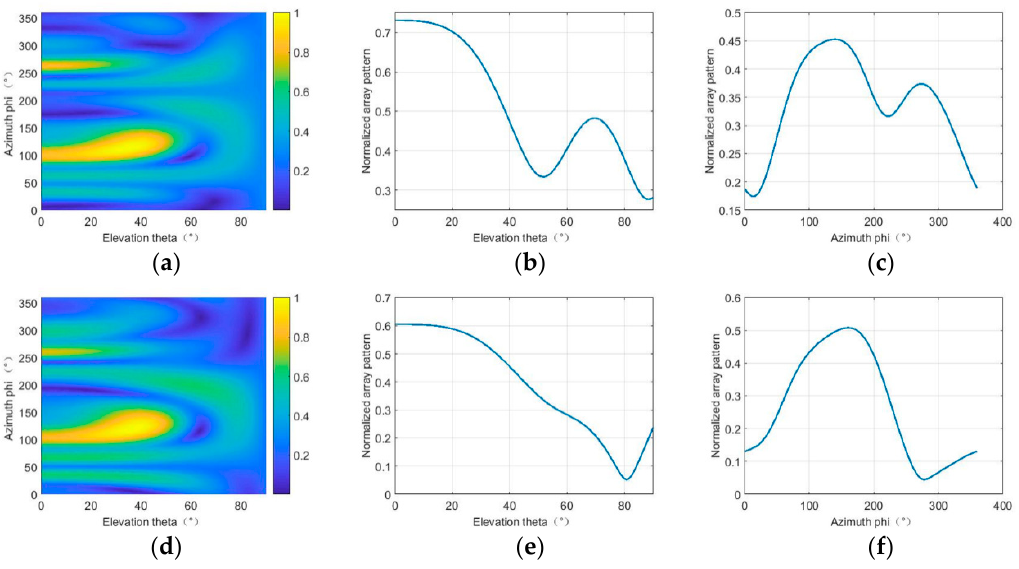
θ  , respectively. ( d –